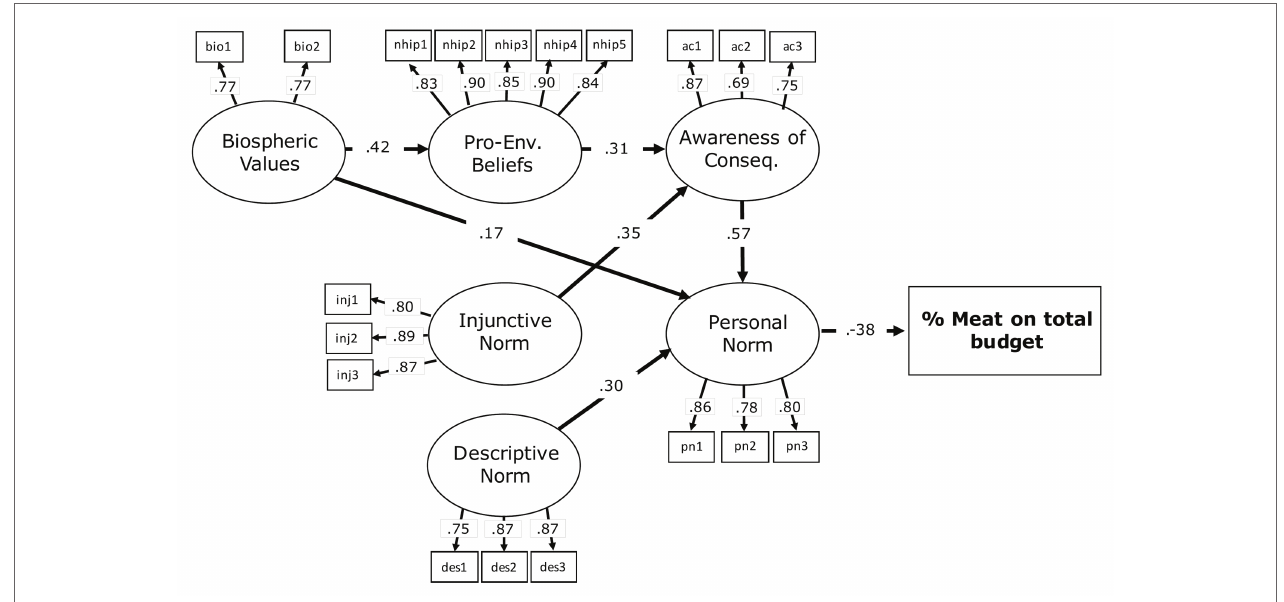
FIGURE 3 | Standardized direct effects and item loadings in the structural model of Study 1. To simplify presentation, the variances – curved double arrows – of the exogenous latent variables and the standardized error variances are not